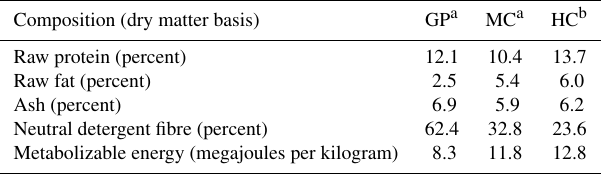
Table 1. Chemical composition of concentrates used in the treat- ments, based on grass pasture (GP) and medium (MC) and high (HC) levels of concentrate in the